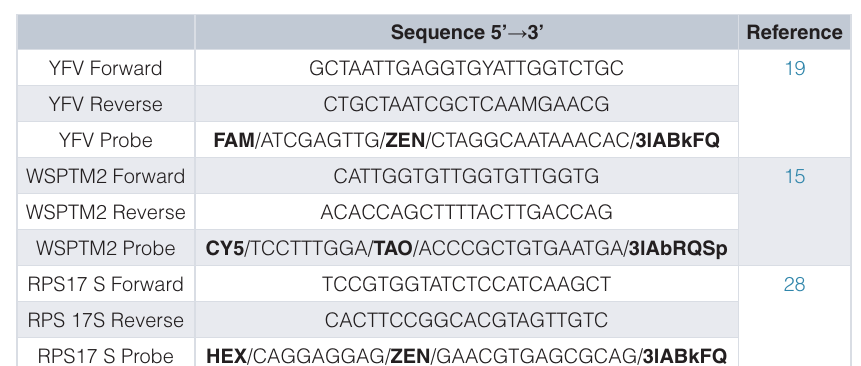
Table 1. Sequence of primers and probes used in this